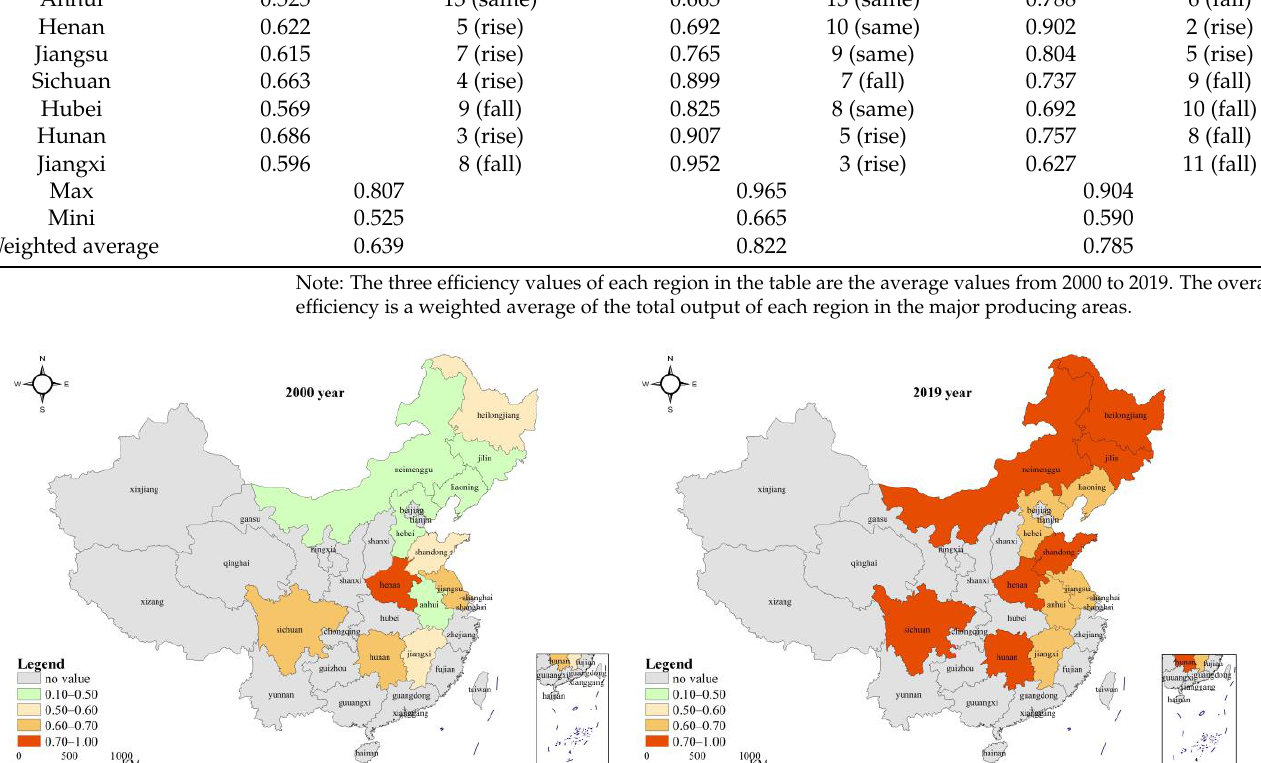
Figure 3. The ranking changes in grain production resource allocation efficiency (comprehensive technical efficiency) in the main grain-producing areas in China after adjustment. In terms of the overall characteristics of comparison, before and after excluding the environmental variables and random factors, the weighted average of comprehensive technical efficiency and scale efficiency of grain production resource allocation efficiency in the major grain-producing areas in China from 2000 to 2019 during the study period decreased as a whole. The comprehensive technical efficiency decreased from 0.733 to 0.639, the scale efficiency decreased from 0.957 to 0.785, and the weighted average of pure